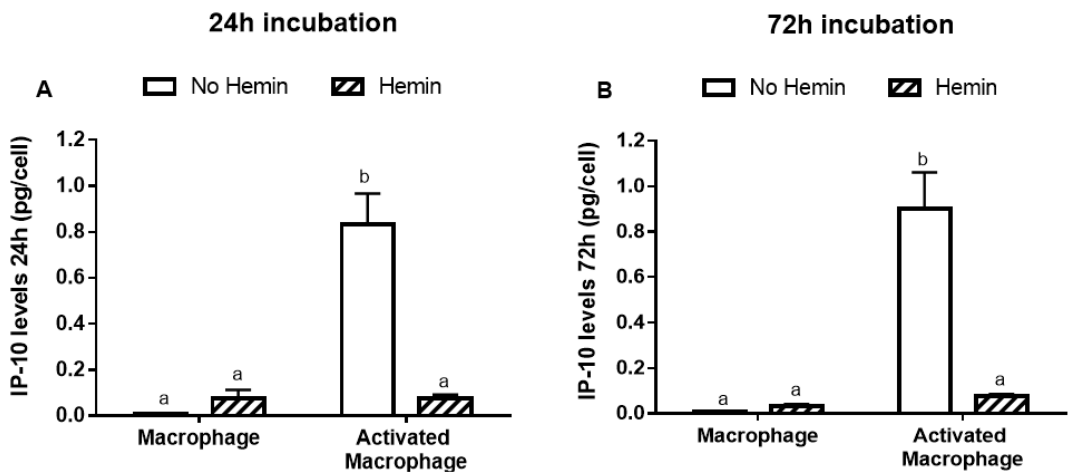
Figure 2. The IP-10 release from macrophages activated with LPS and INF γ is reduced by hemin. Macrophages were incubated for ( A ) 24 or ( B ) 72 h with vehicle in the presence or absence of 10 µ M hemin. Macrophages were also activated for ( A ) 24 or ( B ) 72 h with vehicle or 5 pg / mL LPS and 10 ng / mL INF γ in the presence or absence of 10 µ M hemin. IP-10 levels in the media were quantified at 450 nm and normalized to the cell number. Values with different superscript letters (a and b) indicate significant differences ( p < 0.05) between groups. For all bars with the same letter, the difference between the means is not statistically significant. IP-10, interferon- γ -inducible protein 10.